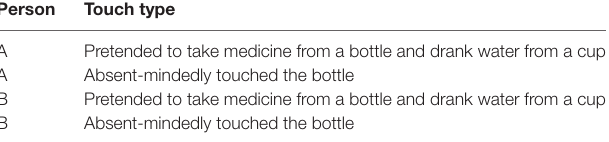
TaBle 2 | Cases per pair of participants (A and B).